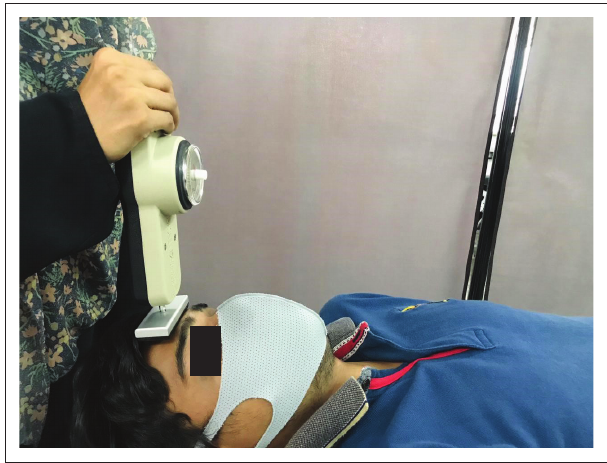
FIGURE 1: Schematic diagram of clinical trial.